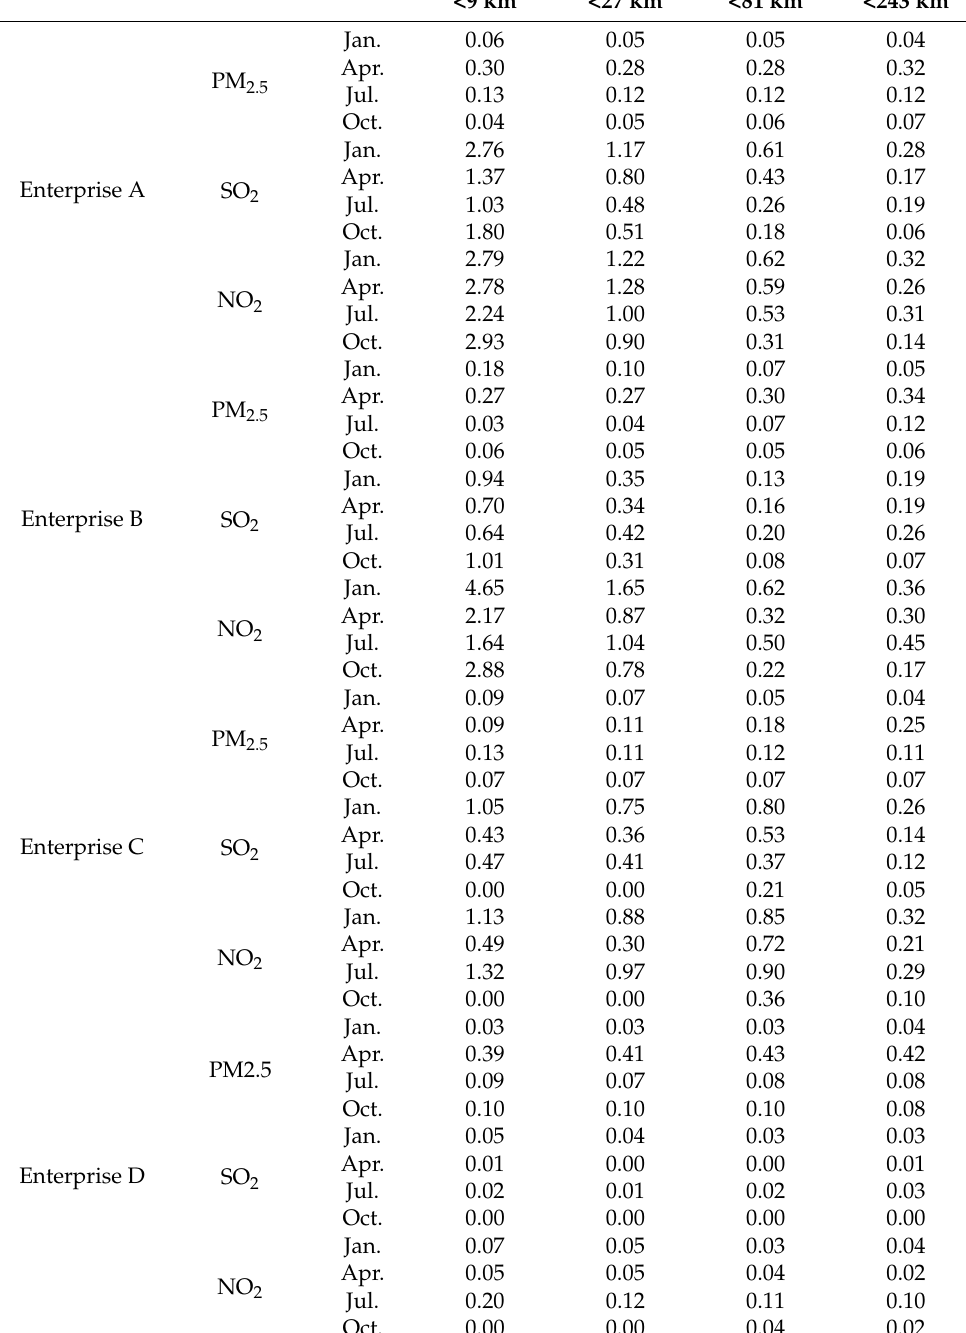
Table 2. Contribution ratio (%) of surface PM 2.5 , SO 2 , and NO 2 concentrations driven by emissions from the four typical petrochemical enterprises within different distances from the